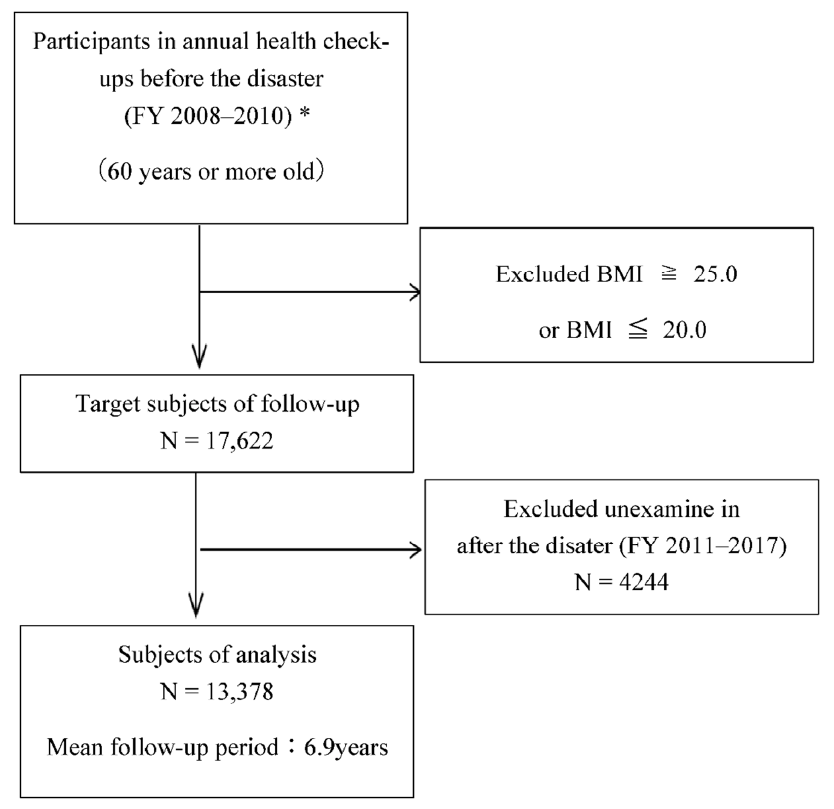
Figure 1. The selection process for the study patients. * In case of duplication, exclude the data of the second and third exams.